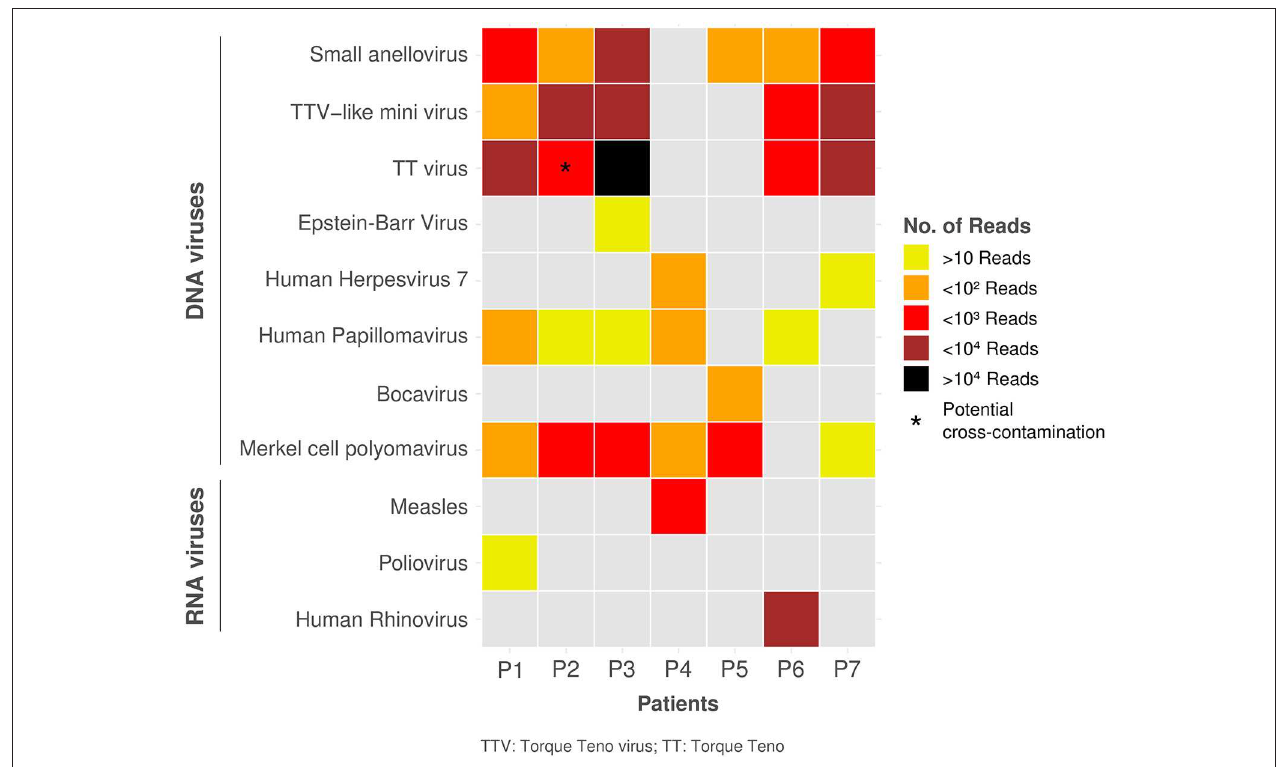
FIGURE 1 | Distribution of identified viruses with number of reads among study